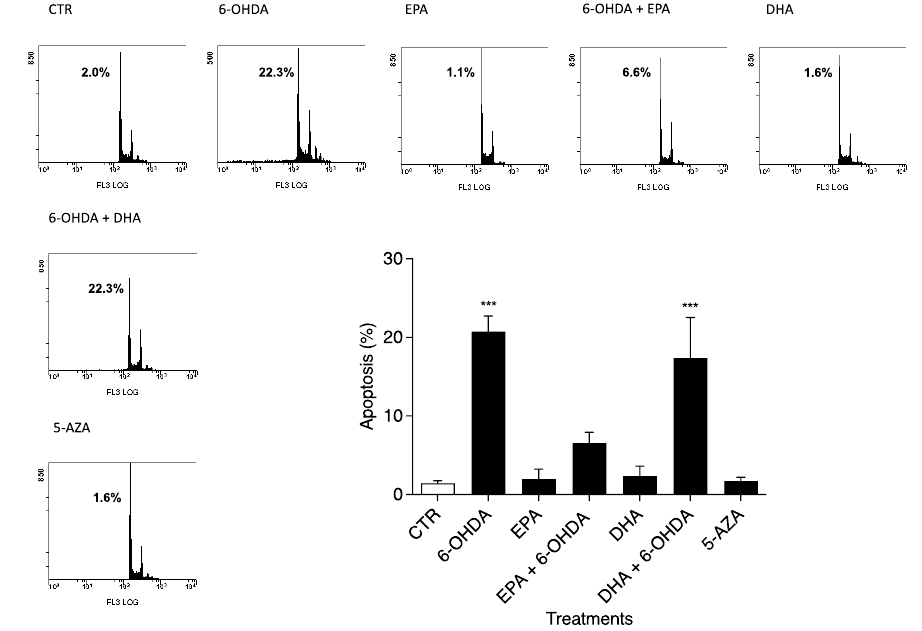
Figure 2. Effects of 6-OHDA, EPA, DHA, and 5-AZA on the apoptosis of SH-SY5Y cell line. Cells were treated for 24 h using 50 µ M 6-OHDA, 100 µ M EPA, 100 µ M DHA, and 1 µ M 5-AZA. Cells were harvested, stained with PI, and analyzed using flow cytometry. Representative plots are reported together with means ± S.D. Data from three independent experiments using four independent cultures per condition were analyzed by ANOVA using Graphpad Prism software * p < 0.01, ** p < 0.001, and *** p < 0.0001 .